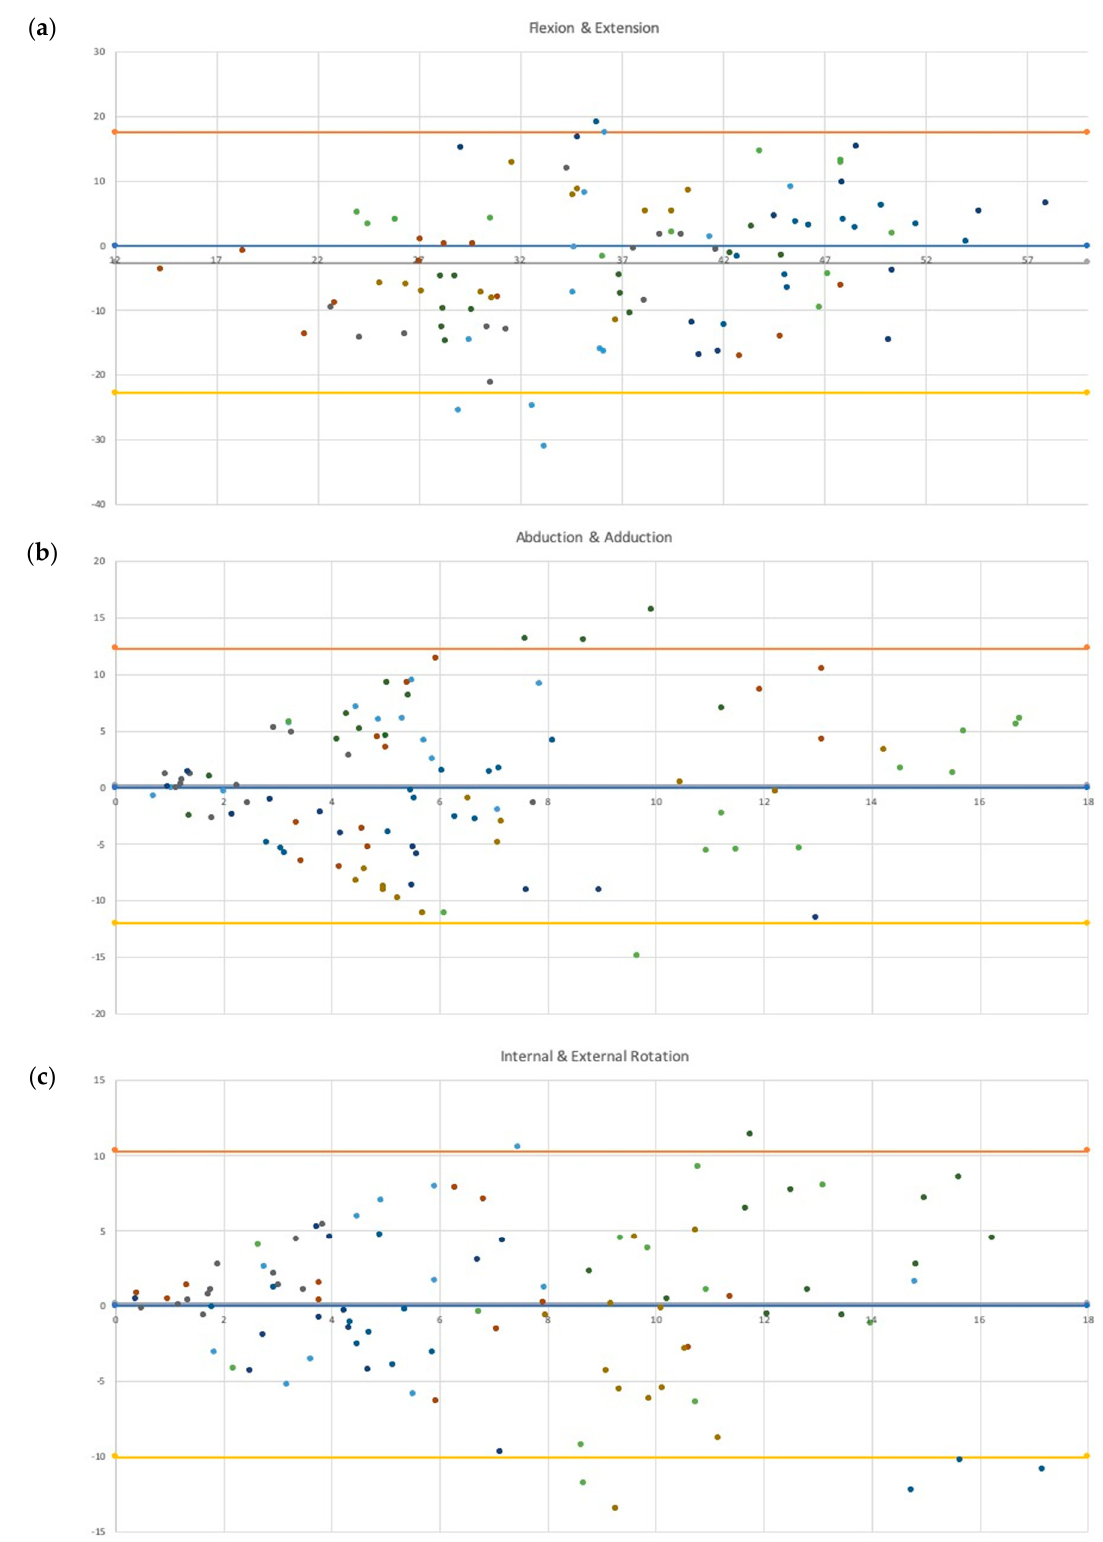
Figure 2. Bland–Altman plot associated with the di ff erence between the ( a ) flexion / extension, ( b ) abduction / adduction, and ( c ) rotation of the inertial measurement unit (IMU) and the motion capture system. The y-axis shows the di ff erence in measured angle between the IMU and motion capture system (Opal-OptiTrack), while the x-axis shows the average measured angle between the